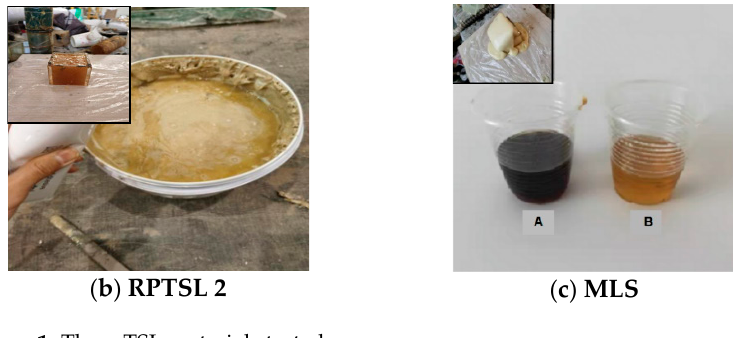
Figure 1. Three TSL materials tested.